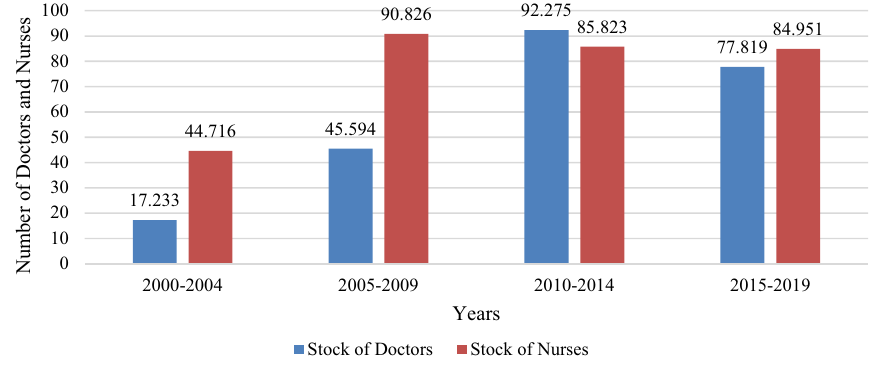
Figure 2. The stock of